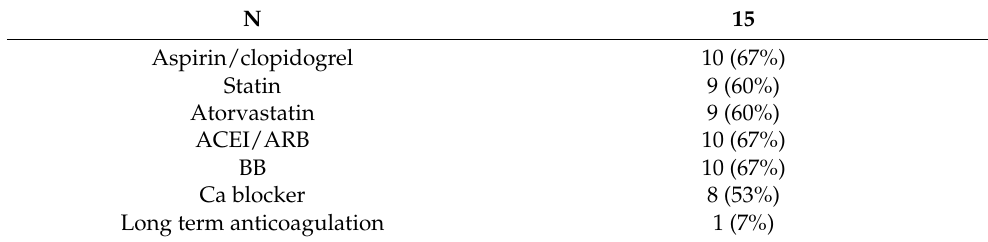
Table 2. Medication before aortic surgery.